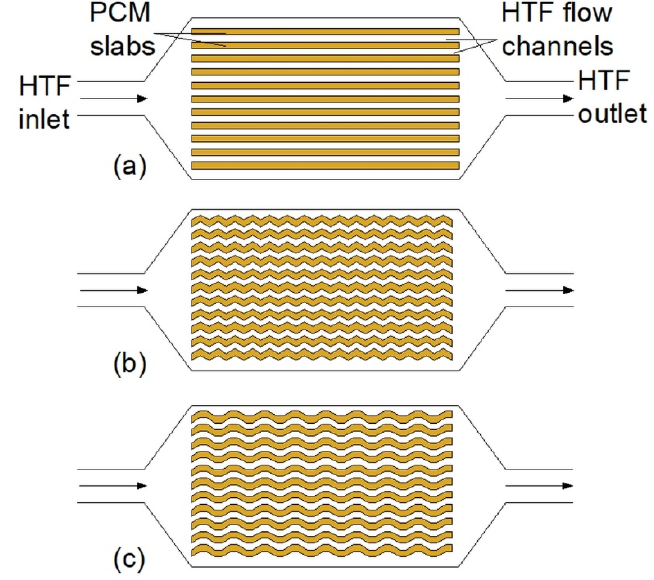
Figure 2. Plate heat exchangers: ( a ) With flat PCM slabs, ( b ) with zigzag PCM slabs [41,45], ( c ) with trapezoidal PCM slabs [63].